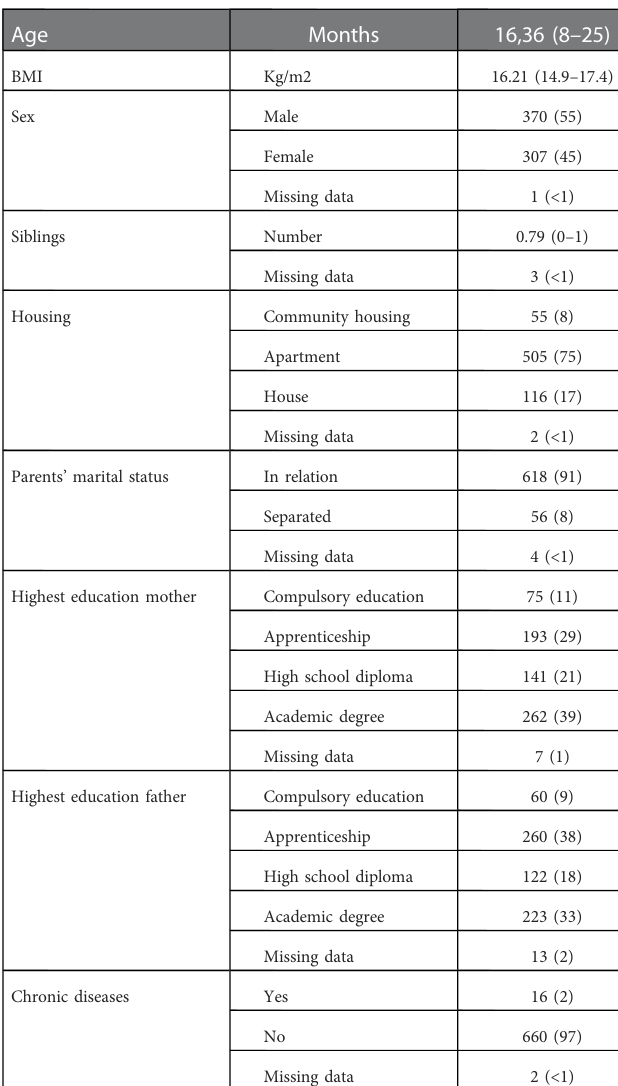
TABLE 1 Characterization of study